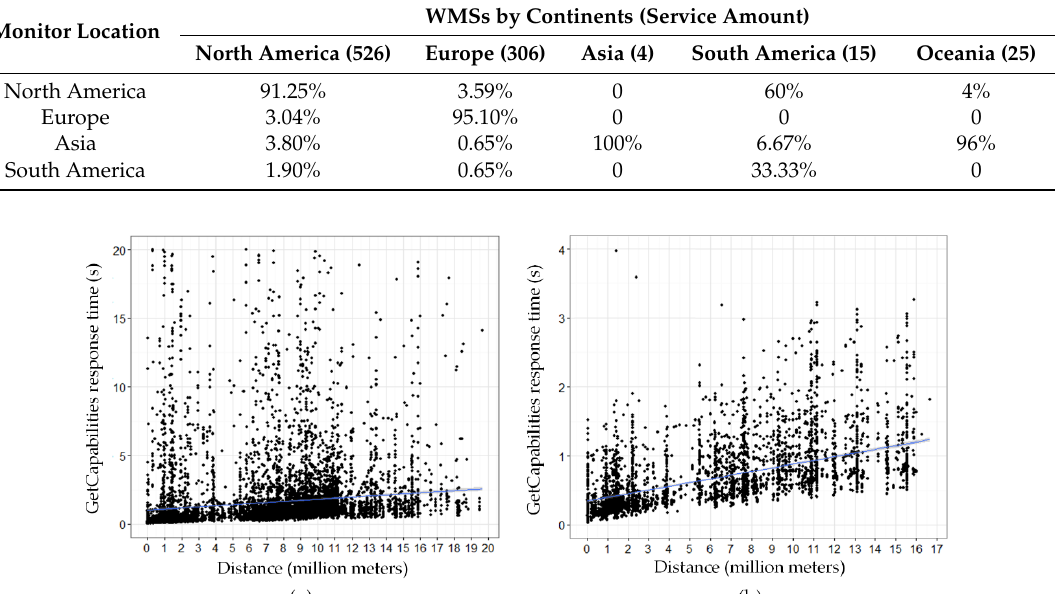
Table 6. The percentage of WMSs from each continent that yielded the shortest average response times from the monitoring sites on each continent.